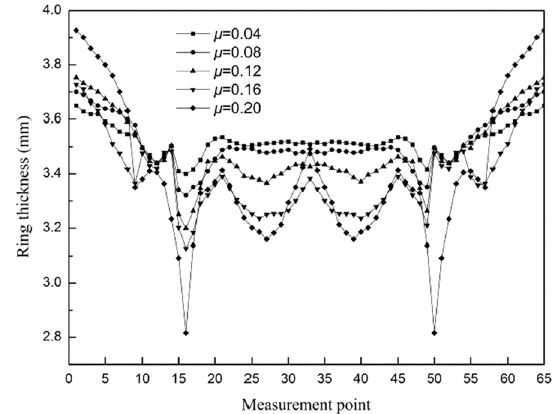
0.04, ( b ) μ 0.08, ( c ) μ 0.12, ( d ) μ 0.16, = = = =